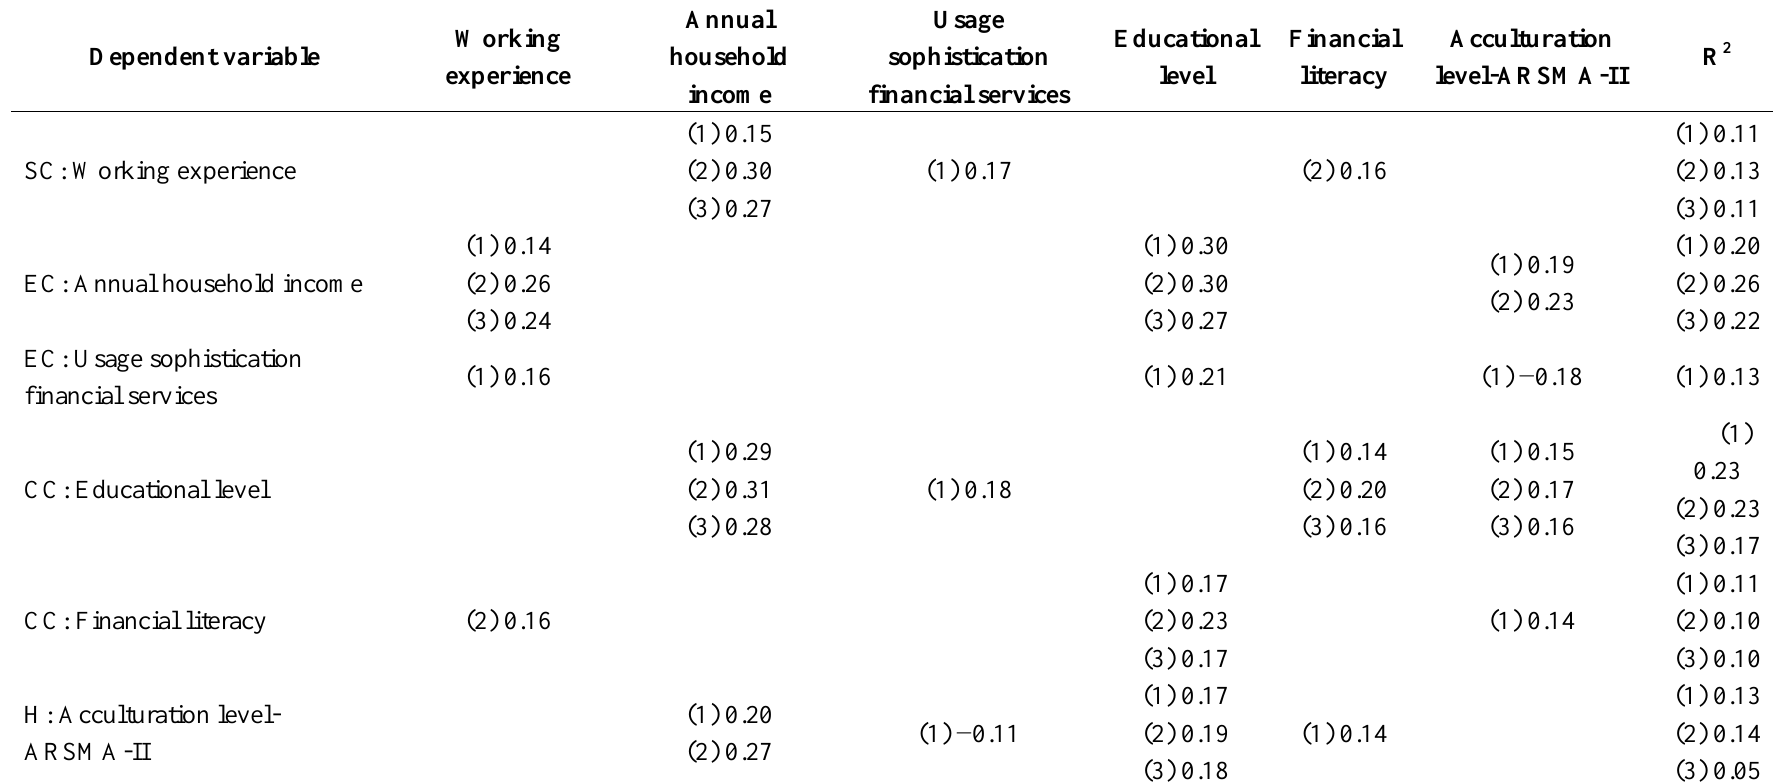
Table 4. Multiple regression results relating the habitus to social, economic, and cultural